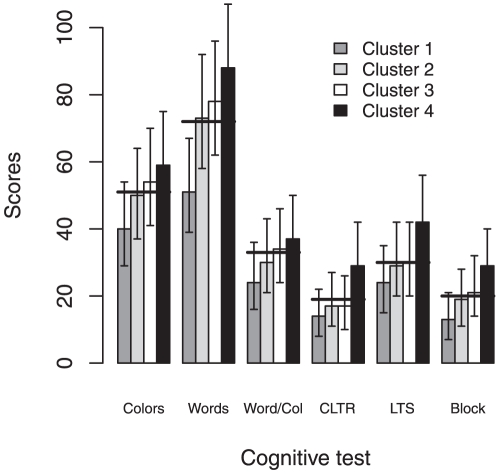
Neurocognitive assessments test scores.Overall (bold horizontal line) and cluster-specific (bars) geometric mean scores for each neurocognitive test. Clusters were identified by the multivariate regression tree analysis. The 95% confidence interval was estimated for the geometric mean for each cluster. Colors, Words and Word/Color indicate the Stroop conditions color naming, word reading and words in colors, respectively. Blocks designates the Block Design subtest of the Wechsler Intelligence. CLTR and LTS, both Selective Reminding Test assessments, refer to the total recalled items in the Consistent Long Term Retrieval and in the Long Term Storage, respectively.